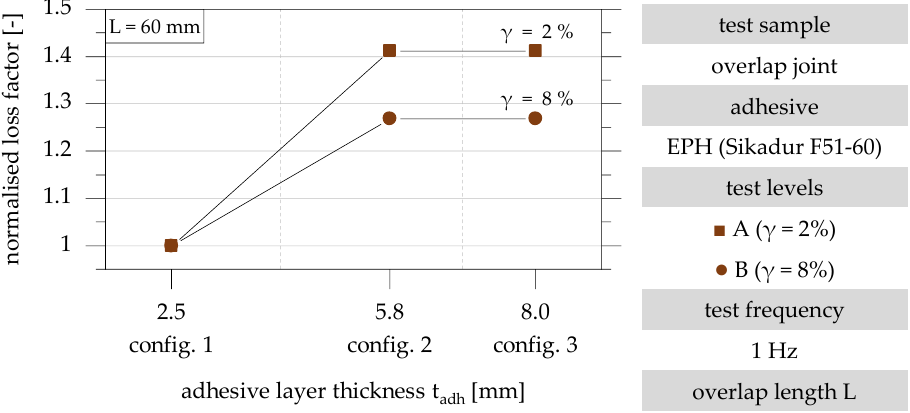
Figure 11. Evaluation of the influence of the overlap length on the loss factor of the overlap joint configurations 1, 2 and 3 with overlap lengths 20 mm and 60 mm in the test levels A and B for the test frequency 1 Hz; representation normalised to the loss factor of the specimens with overlap length 20 mm based on [22].